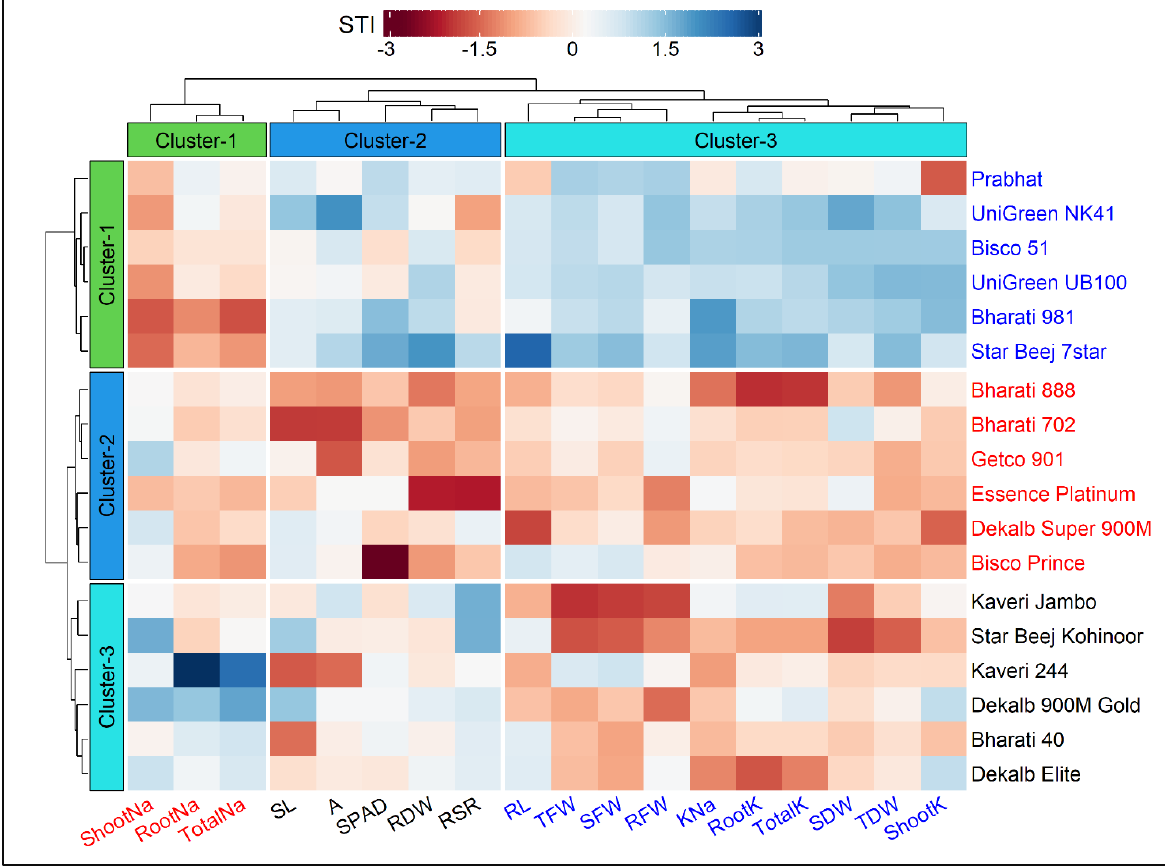
Figure 3. Hierarchical clustering and heatmap illustrating the associations among 18 maize cultivars and 18 different traits under salt condition. Each column represents a trait, whereas each row represents a cultivar. The different colors and intensities were adjusted based on cultivars–traits relationships. Colors are representative of a relative scale (−3 to +3) and derived from data standardization of the STI (salt tolerance index) values. The darker red indicates lower values (salt − sensitive), while the darker blue indicates higher values (salt − tolerant). Both the cultivars and traits were grouped into three clusters each. RL (Root Length, cm), SL (Shoot Length, cm), RFW (Root Fresh Weight, g), SFW (Shoot Fresh weight, g), TFW (Total Fresh Weight, g), RDW (Root Dry Weight, g), SDW (Shoot Dry Weight, g), TDW (Total Dry Weight, g), RSR (Root–Shoot Ratio), SPAD (Leaf Greenness), A (Photosynthesis rate, µ mol CO 2 m − 2 s − 1 ), RootK (Root K + concentration, mg g − 1 DW), ShootK (Shoot K + concentration, mg g − 1 DW), TotalK (Total K + concentration, mg g − 1 DW), RootNa (Root Na + concentration, mg g − 1 DW), ShootNa (Shoot Na + concentration, mg g − 1 DW), TotalNa (Total Na + concentration, mg g − 1 DW), KNa (K + –Na +